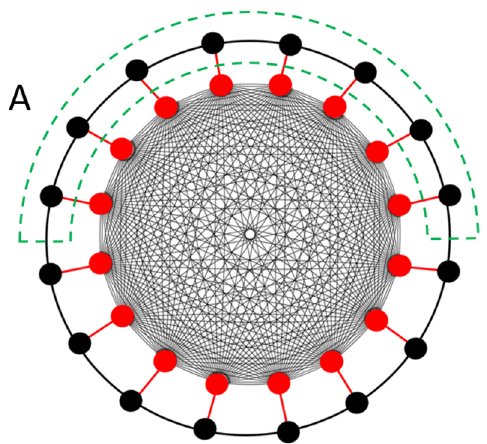
Figure 6 . A schematic plot of regions between which we choose to calculate the second Rényi entropy in the main text. The region inside the green dashed line is region A , and the compli- ment is region B . If the local Majorana do not couple to the chaotic Majorana, any information transmission between two regions must travel through the boundary and the speed of it is given by the quasiparticle velocity. Whereas, if the coupling is nonzero, non-local information can transmit much faster with the help of the chaotic Majorana.